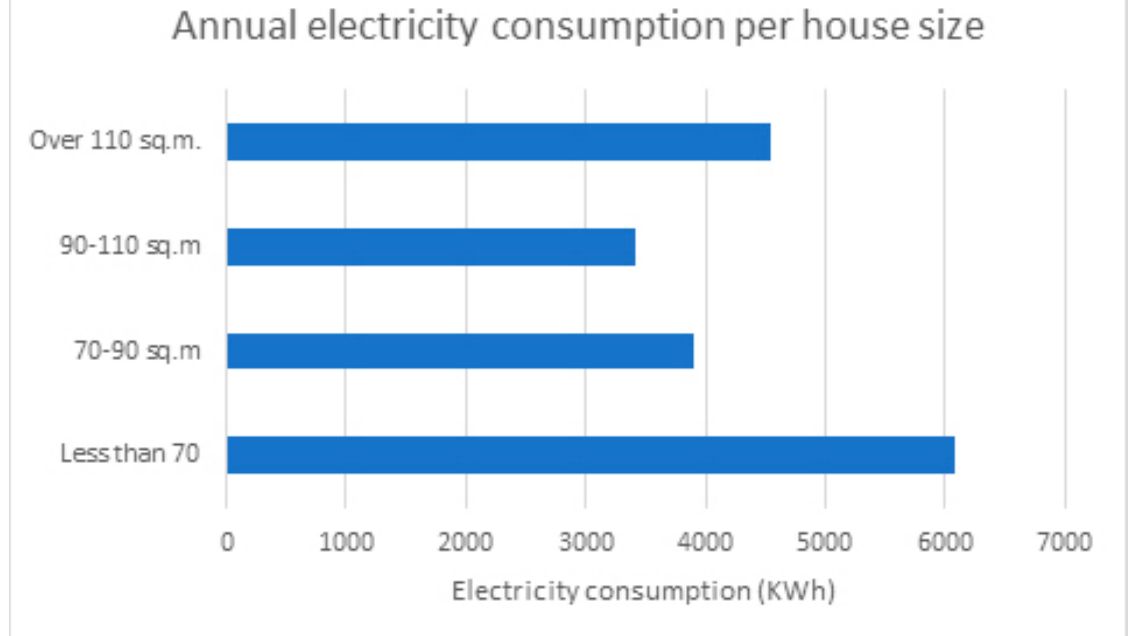
Figure 7. Average annual electricity consumption in relation to house size. In general, annual electricity consumption increases proportionally to the household size, with households consisting of three members presenting higher consumption (Fig- ure 8). Interestingly, the annual electricity consumption is considerably higher for house- holds using special tariffs, i.e., night and social tariffs (Figure 9), coinciding with the “stated” electricity cost in relation to the tariff scheme (Section 3.1).